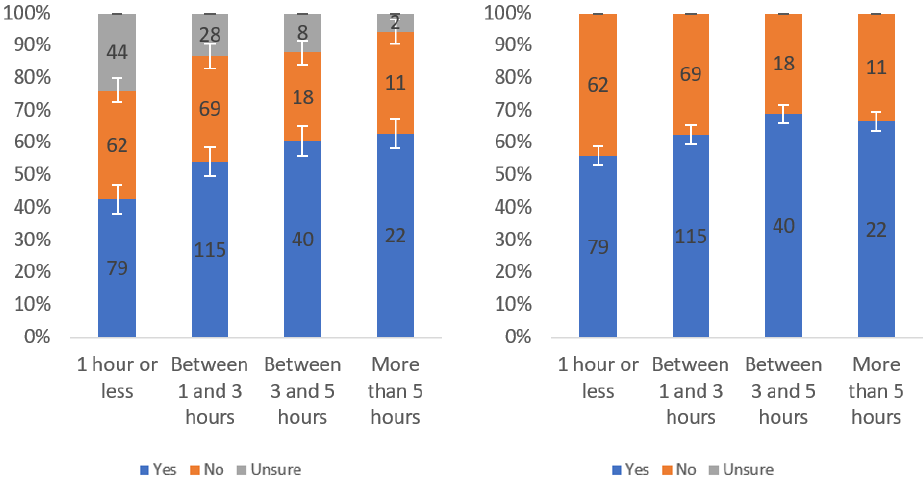
Figure 69. Responses regarding usefulness in judging trustworthiness by internet usage level in- cluding ( left ) and excluding ( right ) unsure responses. ing ( left ) and excluding ( right ) unsure